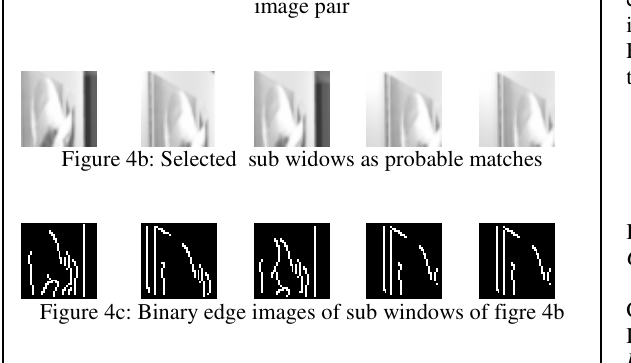
Figure 4a: Template window from left image from stereo image pair